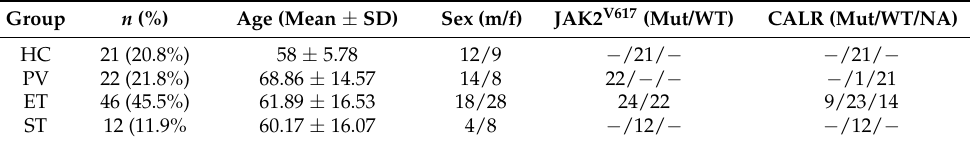
Table 2. Clinical characteristics of the patients included in the